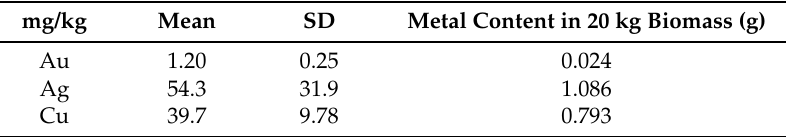
Table 2. Metal concentration in dry biomass and the calculated metal content (g) in the 20 kg of harvested dry biomass. Concentration values are the mean and standard deviation of replicate analysis of the five bulk samples received in New Zealand ( n =